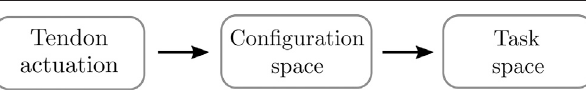
FIGURE 2 | The modelling framework of a TDCR that considers the tendon actuation to calculate the resulting con fi guration space parameters. The con fi guration space parameters can then be used to obtain the corresponding backbone shape in 3D